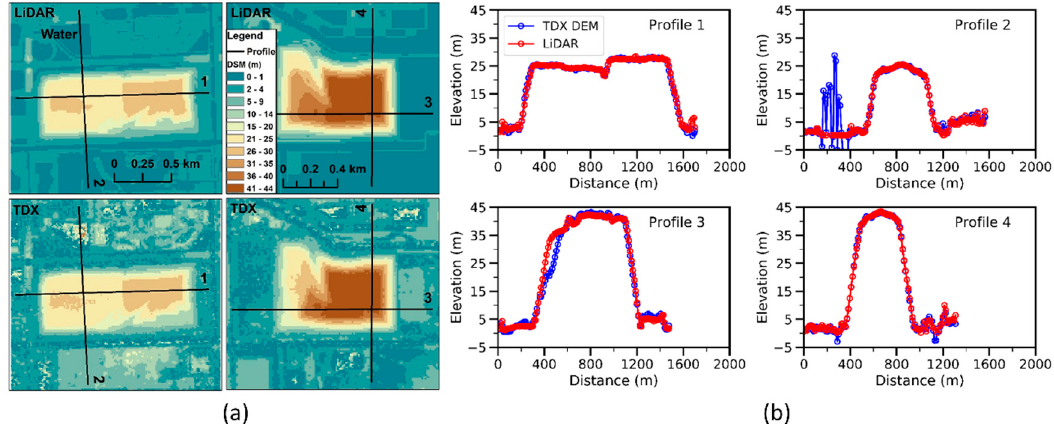
Figure 5. ( a ) TDX DEM of 12 m pixel size and corresponding LiDAR DSM of two trash mounds for profile analysis. Note that the TDX DEM image shows more noise than LiDAR DSM, especially in water bodies. ( b ) Elevation profiles extracted from TDX DEM and LiDAR DSM for two trash